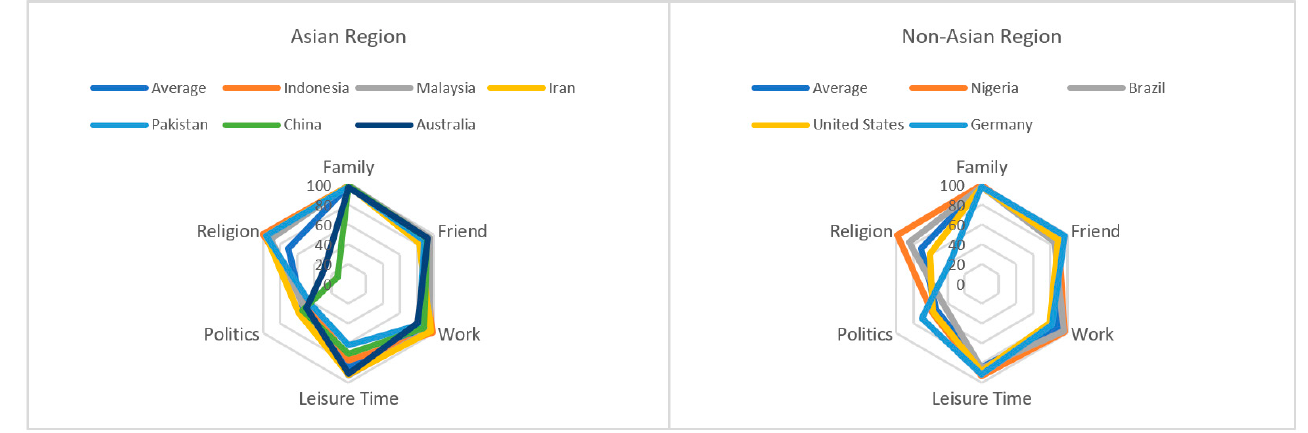
Figure 2. Important values in life by Asian and Non-Asian Regions.